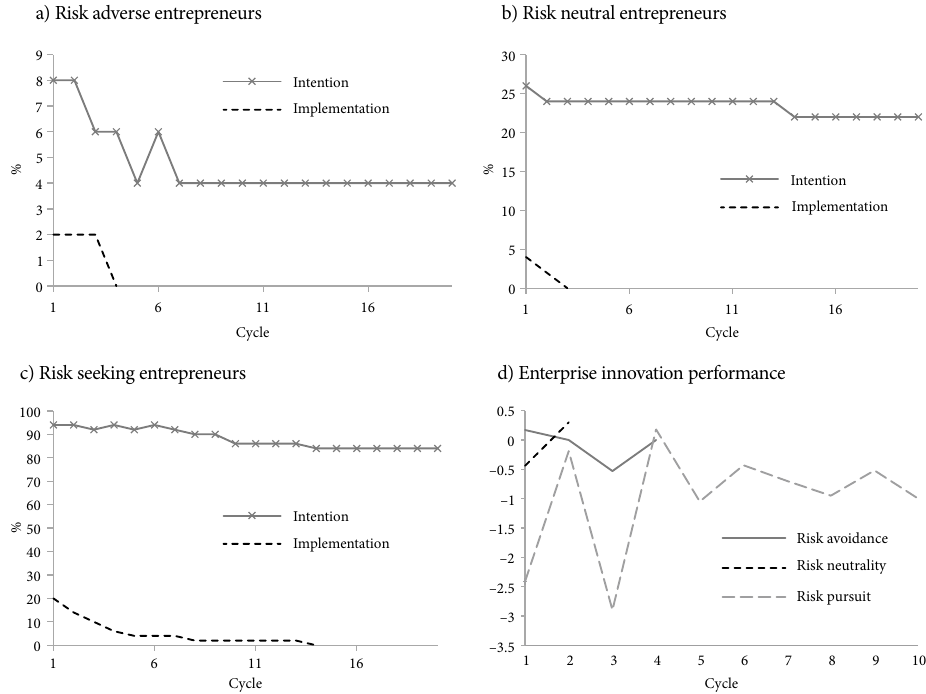
Figure 4. Evolution of spontaneous innovation behavior of new generation entrepreneurs